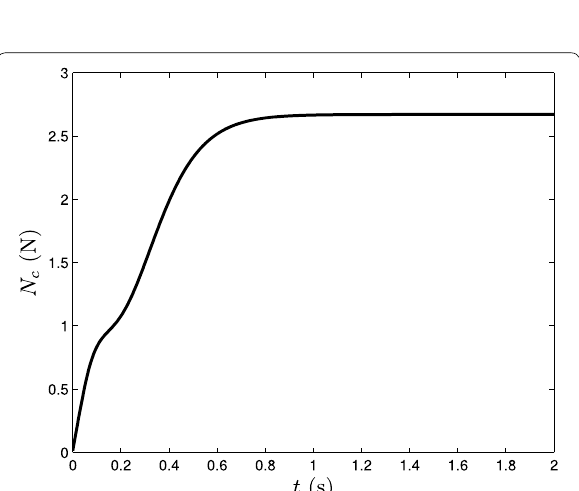
Fig. 9 Slippage parameter